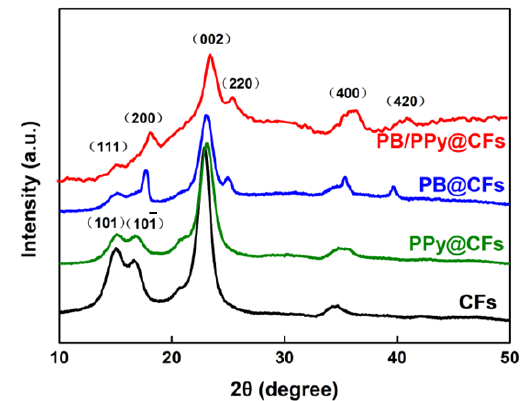
Figure 4. XRD curves of CFs, PPy@CFs, PB@CFs, and